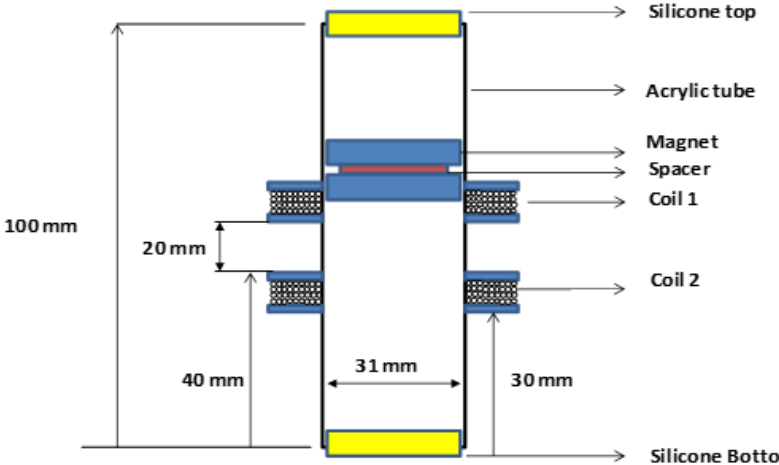
Figure 3. LEG configuration and dimensions